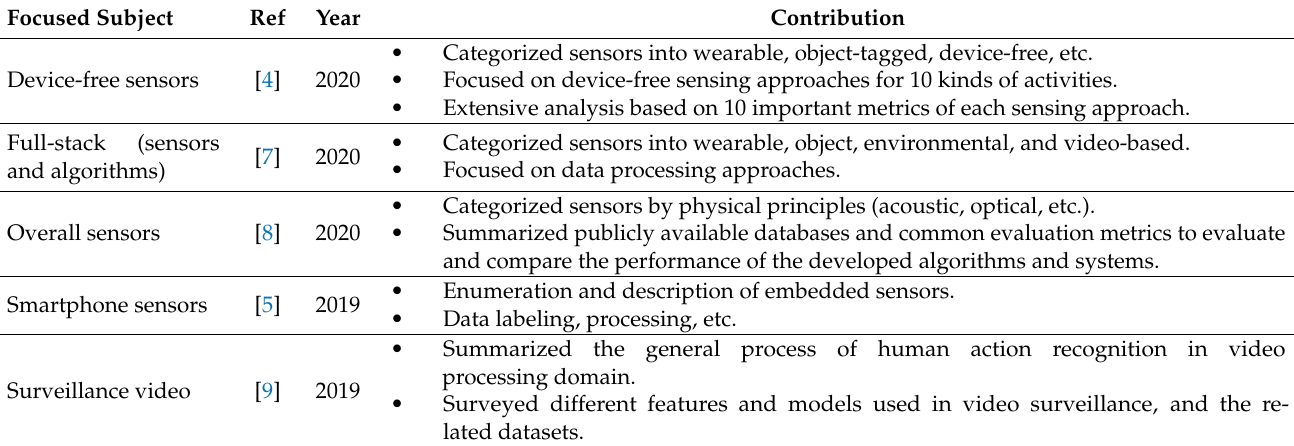
Table 1. Surveys on HAR sensing